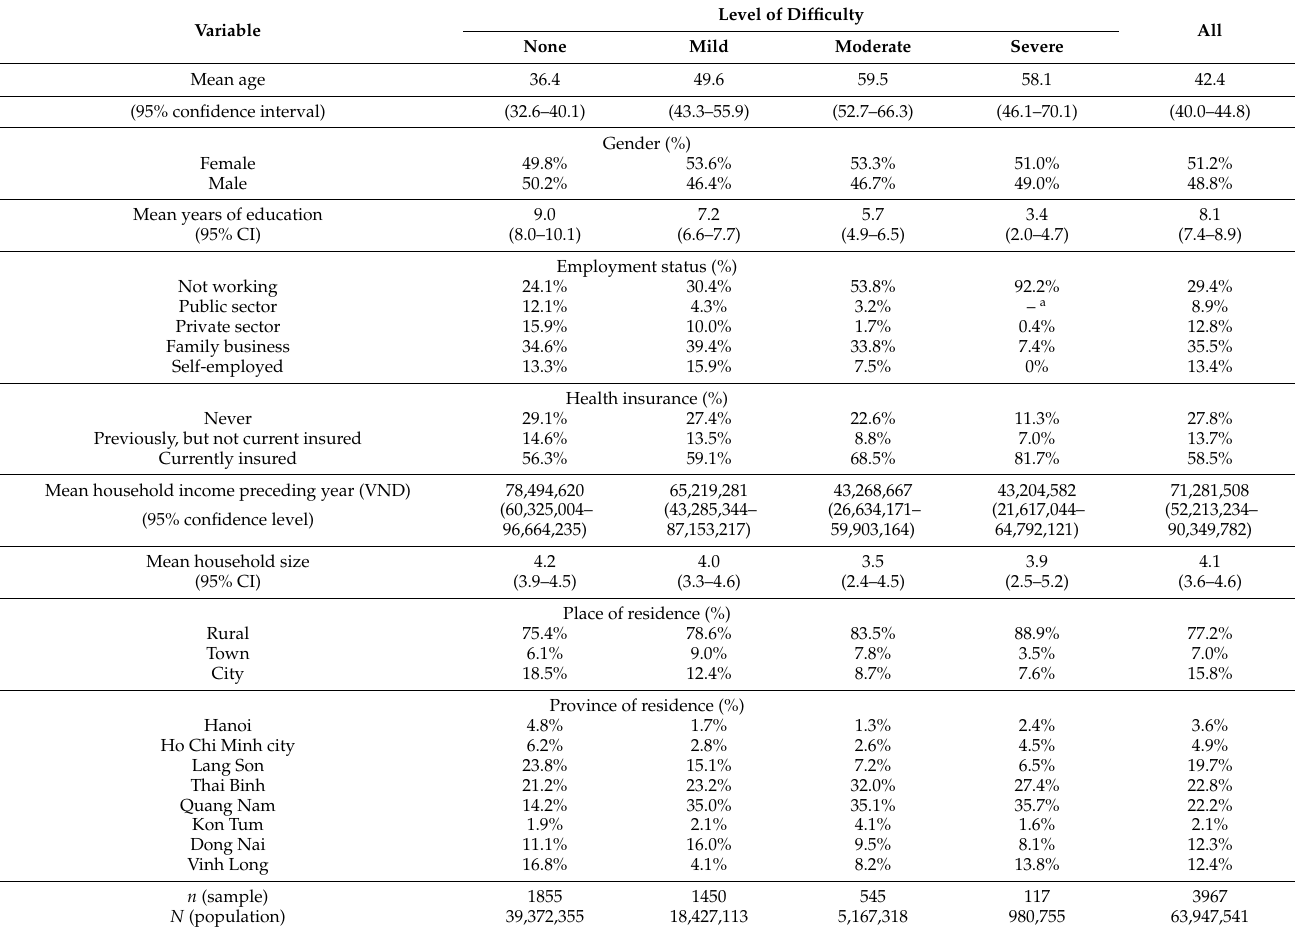
Table 1. Demographic and socio-economic characteristics of the study